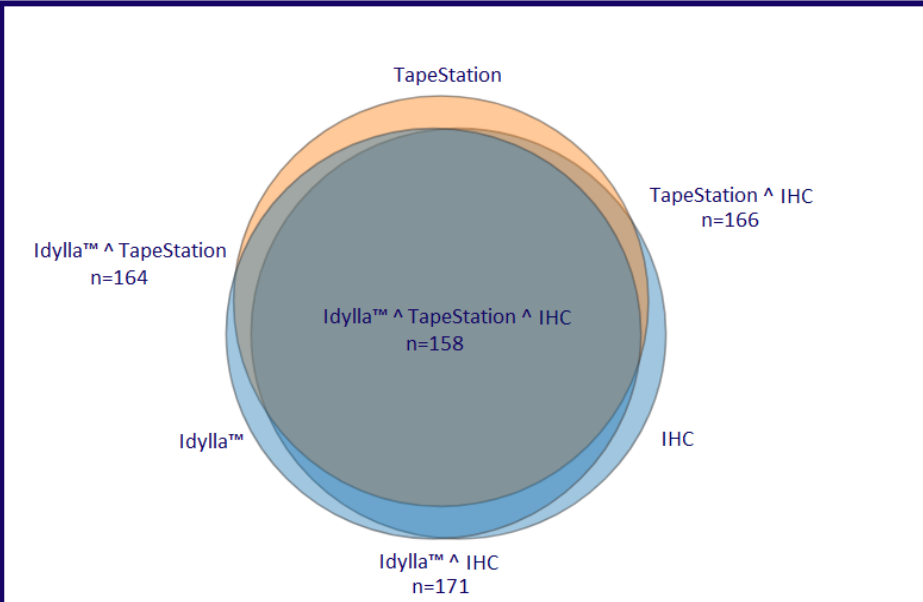
Figure 2. Venn diagram representing the concordance rate among the technologies adopted in the present study. Briefly, dark gray circle represents fully concordant cases among the three different assays; dark gray plus dark orange circles represent the concordant cases between TapeStation 4200 and IHC; dark gray and dark blue circles represent the concord-